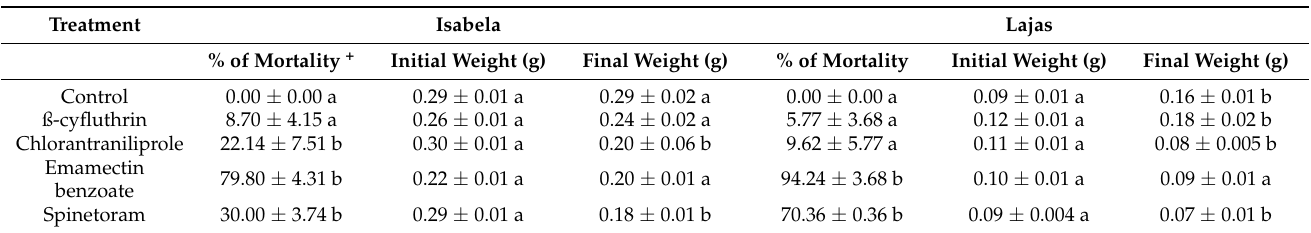
Table 9. Mean ( ± SE) of percentages of mortality for fall armyworm ( Spodoptera frugiperda (J. E. Smith) (Lepidoptera: Noctuidae)) larvae and their initial and final weight evaluated at 96 h after insecticide application in